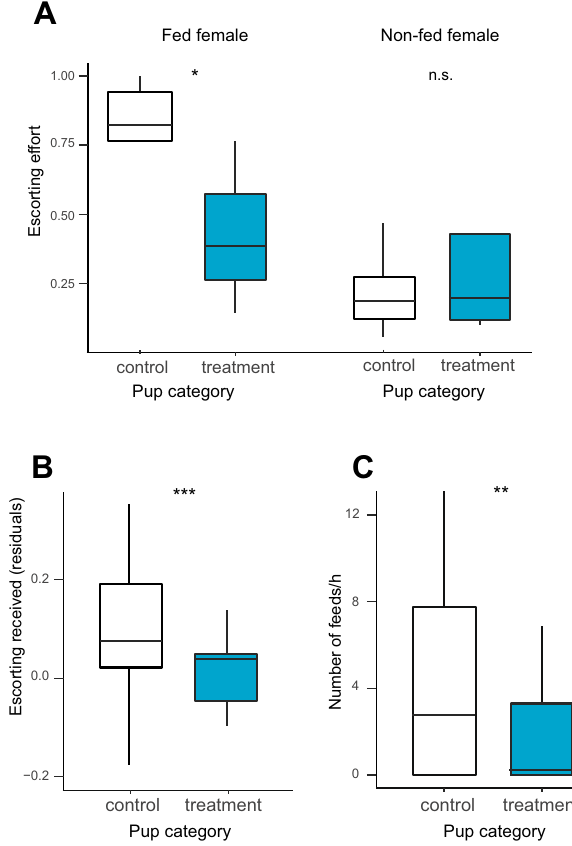
Fig. 3 Pattern of postnatal care. A Escorting effort (proportion of time spent escorting) directed to control (unshaded) and treatment (sky blue) pups by fed females and non-fed females. B Overall escorting received by control and treatment pups (residual values plotted once other variables are controlled for in our statistical model, Table S6). C Rates at which the control and treatment pups were fed by their escort. Boxes show the interquartile range (IQR) and median (internal horizontal line). Whiskers (vertical lines) show the extent of observations outside the IQR to a maximum of 1.5x IQR. Other legends: n.s.: p > 0.05; * p < 0.05; ** p < 0.01; *** p <